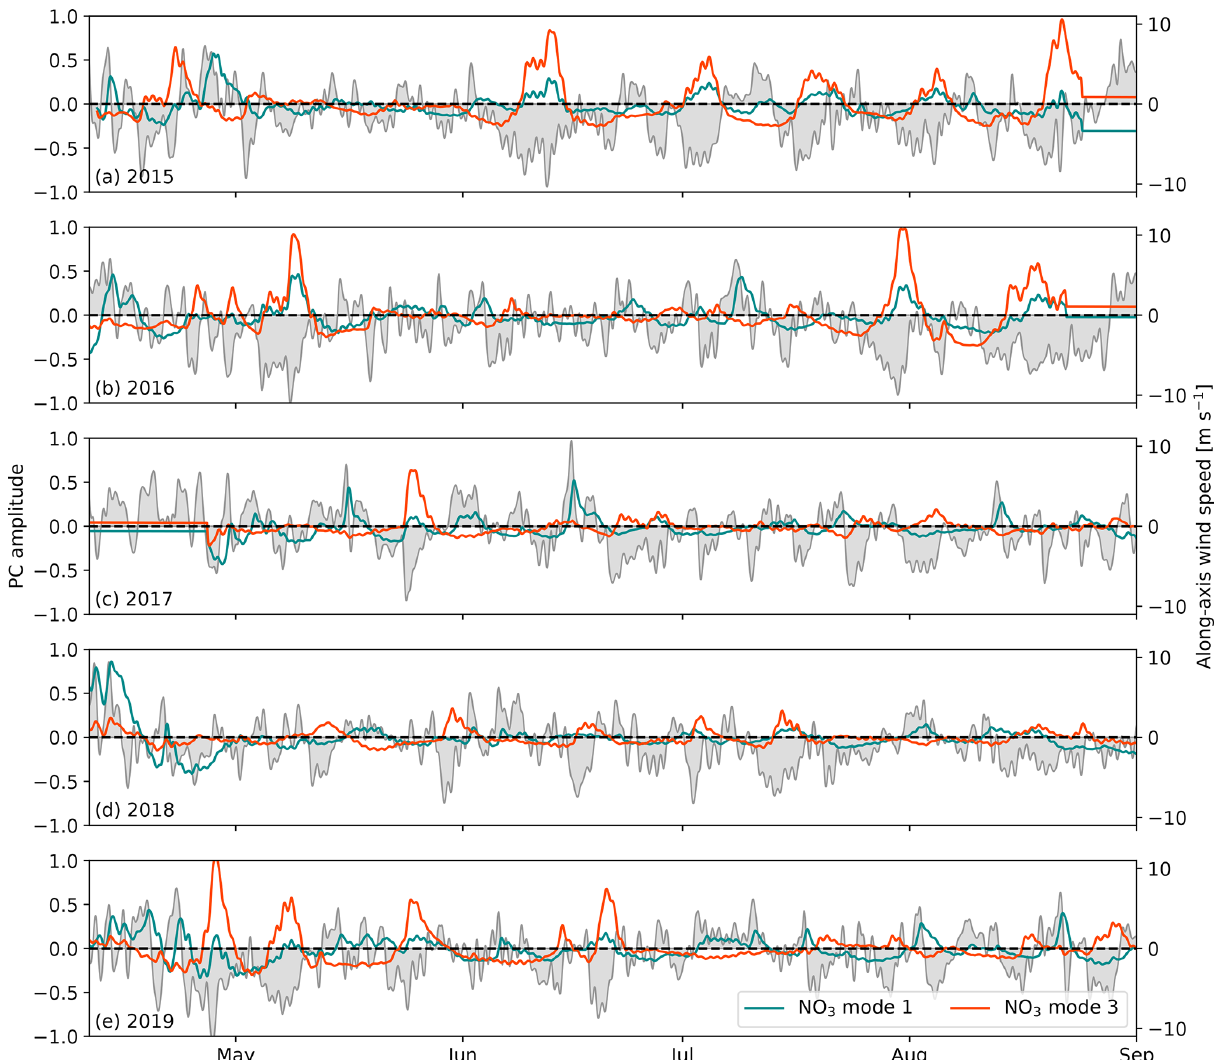
Figure 7. Time series of the principal component (PC) loadings for surface nitrate modes 1 and 3 corresponding to the EOF spatial patterns shown in Fig. 6. The spatial median of along-axis HRDPS wind speed over the open-water region in Fig. 4a (magenta region) is also shown. The PC and wind time series are low-pass filtered using a 1d Blackman window cutoff in order to emphasize the low-frequency variability. The PC loadings of both nitrate modes increase during sustained wind